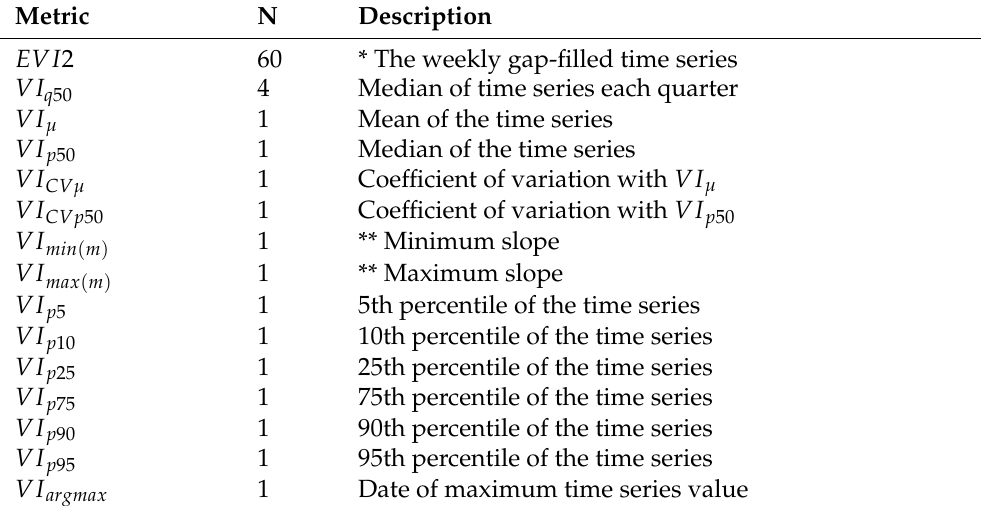
Table 2. Features used for vegetation indices EVI2 and WI ( VI ) to fit classification models for each grid cell. * The weekly time series were generated for EVI2 and WI and used to calculate aggregate metrics. However, only the EVI2 weekly values were used as predictive features. ** The maximum and minimum slopes were computed with a moving window of 1.5 month